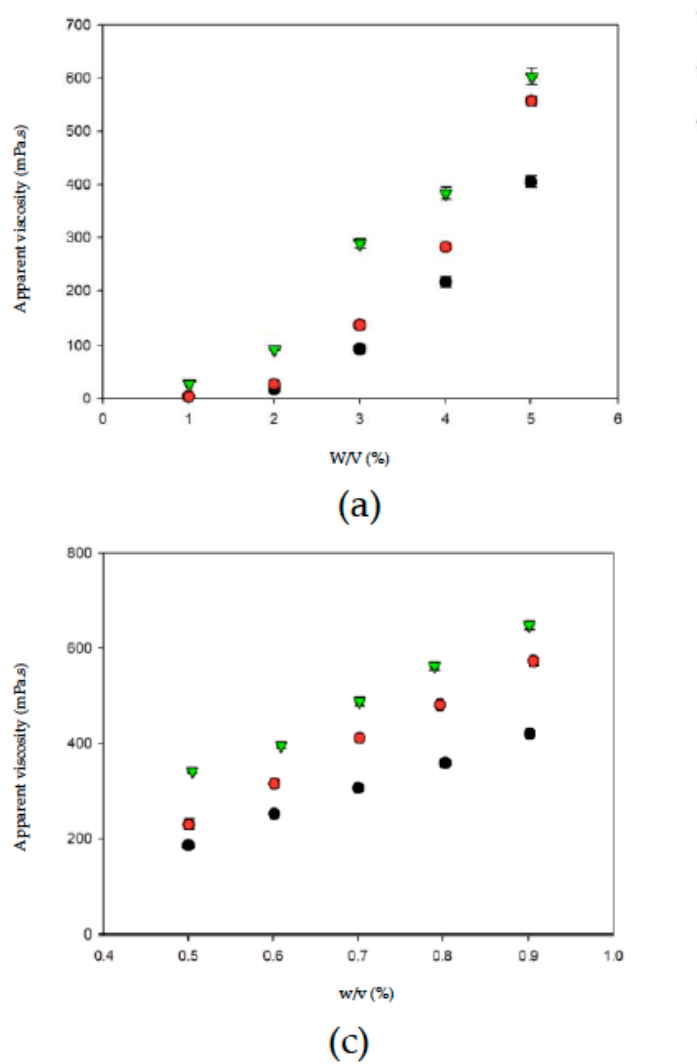
Figure 4. The weight-dependent ( w ) apparent viscosity with respect to thickeners incorporated into aquatic bases ( w/v %). Water ( ● ); sport drink ( ● ); orange juice ( ▼ ). Error bars represent standard deviations. Thickeners: ( a ) tapioca starch; ( b ) hydroxypropyl distarch phosphate; ( c ) xanthan gum. Table 1. Correlations between apparent viscosity (y with unit of mPa.s) and combinations of thickeners and aquatic bases. Thickener Base Equation